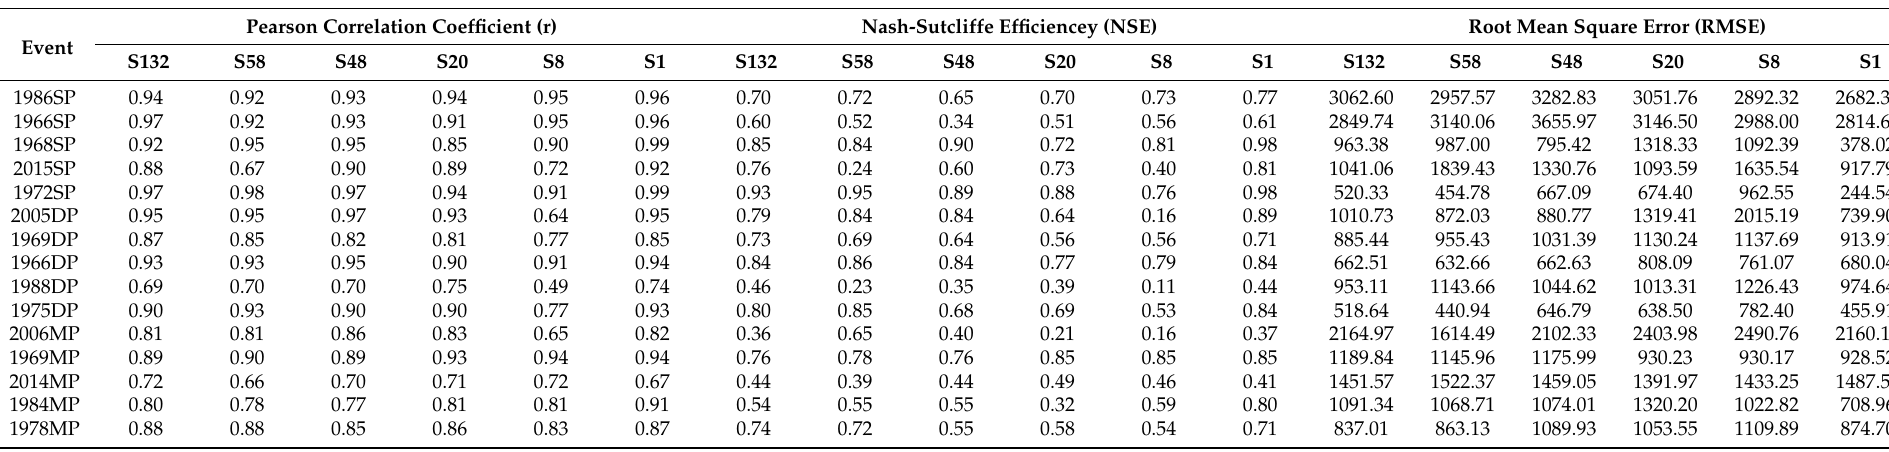
Table A2. Verification metrics for streamflow simulations of the calibration scenario; verification metrics from left to right column are r, NSE, RMSE, MAE, PBIAS and PEP for six configurations, and each row corresponds to an